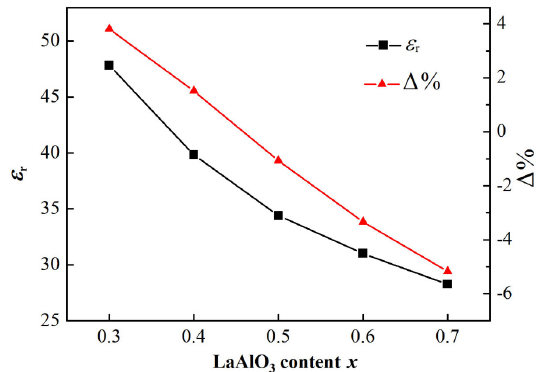
Fig. 4 Dielectric constant (  ) and polarizability r deviation (Δ%) of the CTLA ceramics sintered at 1450 ℃ for 4 h. Table 2 Comparison of the observed and theoretical polarizabilities of the CTLA ceramics with different LaAlO 3 content sintered at 1450 ℃ for 4 h Observed x